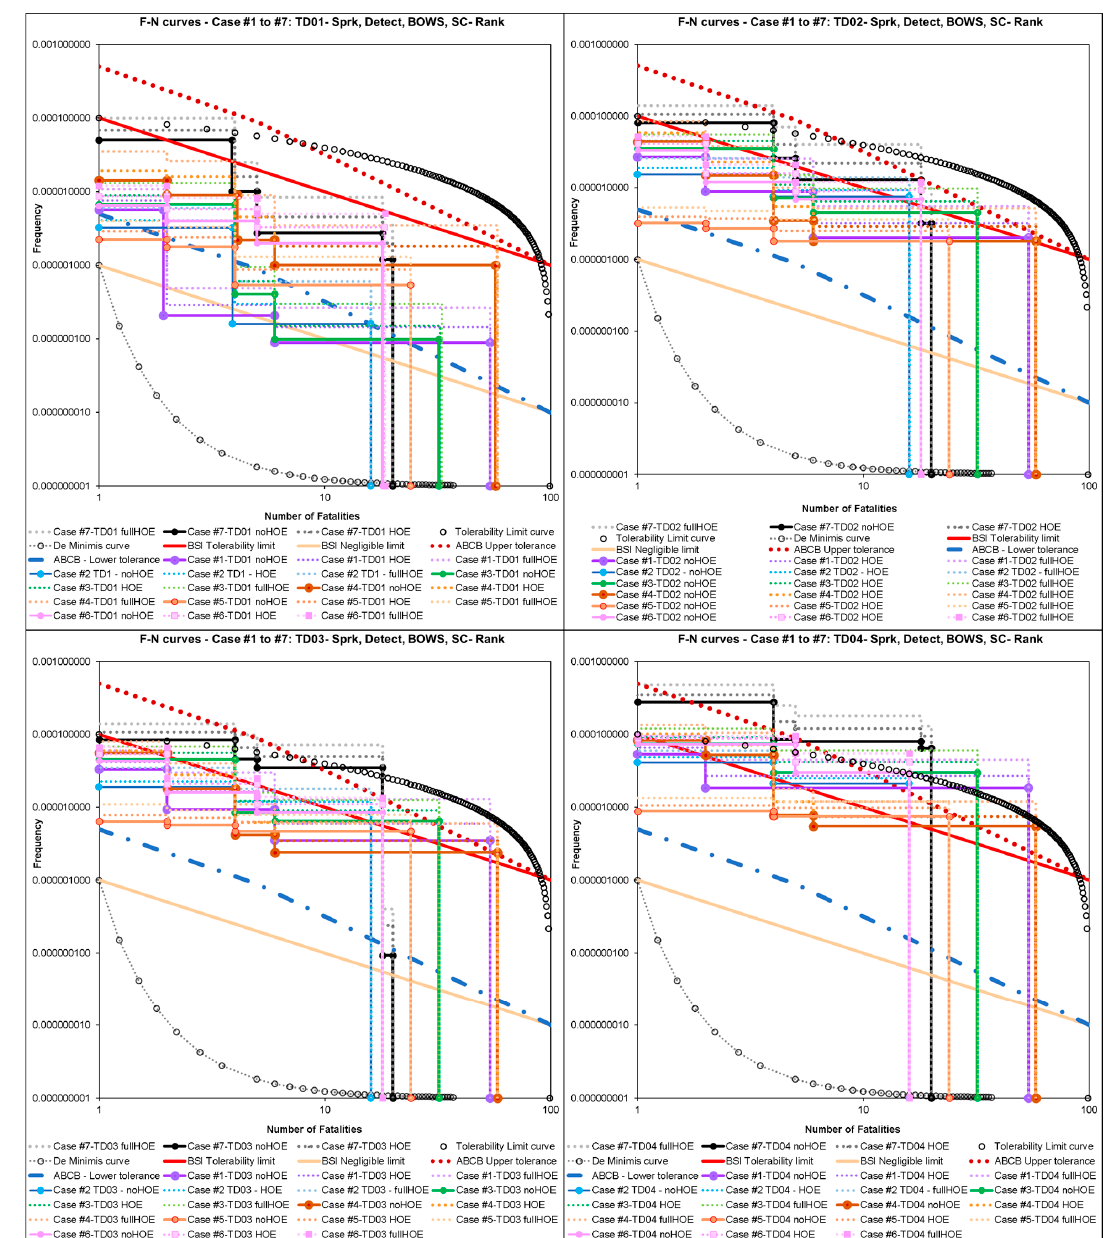
Figure 5. F-N curves for Case #1 to Case #7: TD01 to TD04: noHOE, HOE, fullHOE.